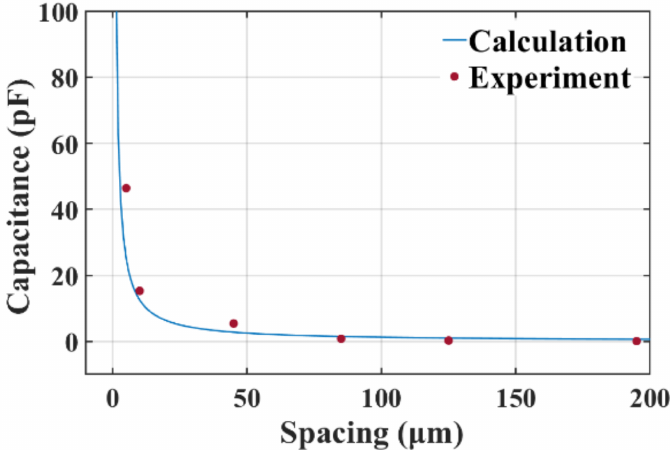
Figure 8. Calibration results of the capacitive spacing